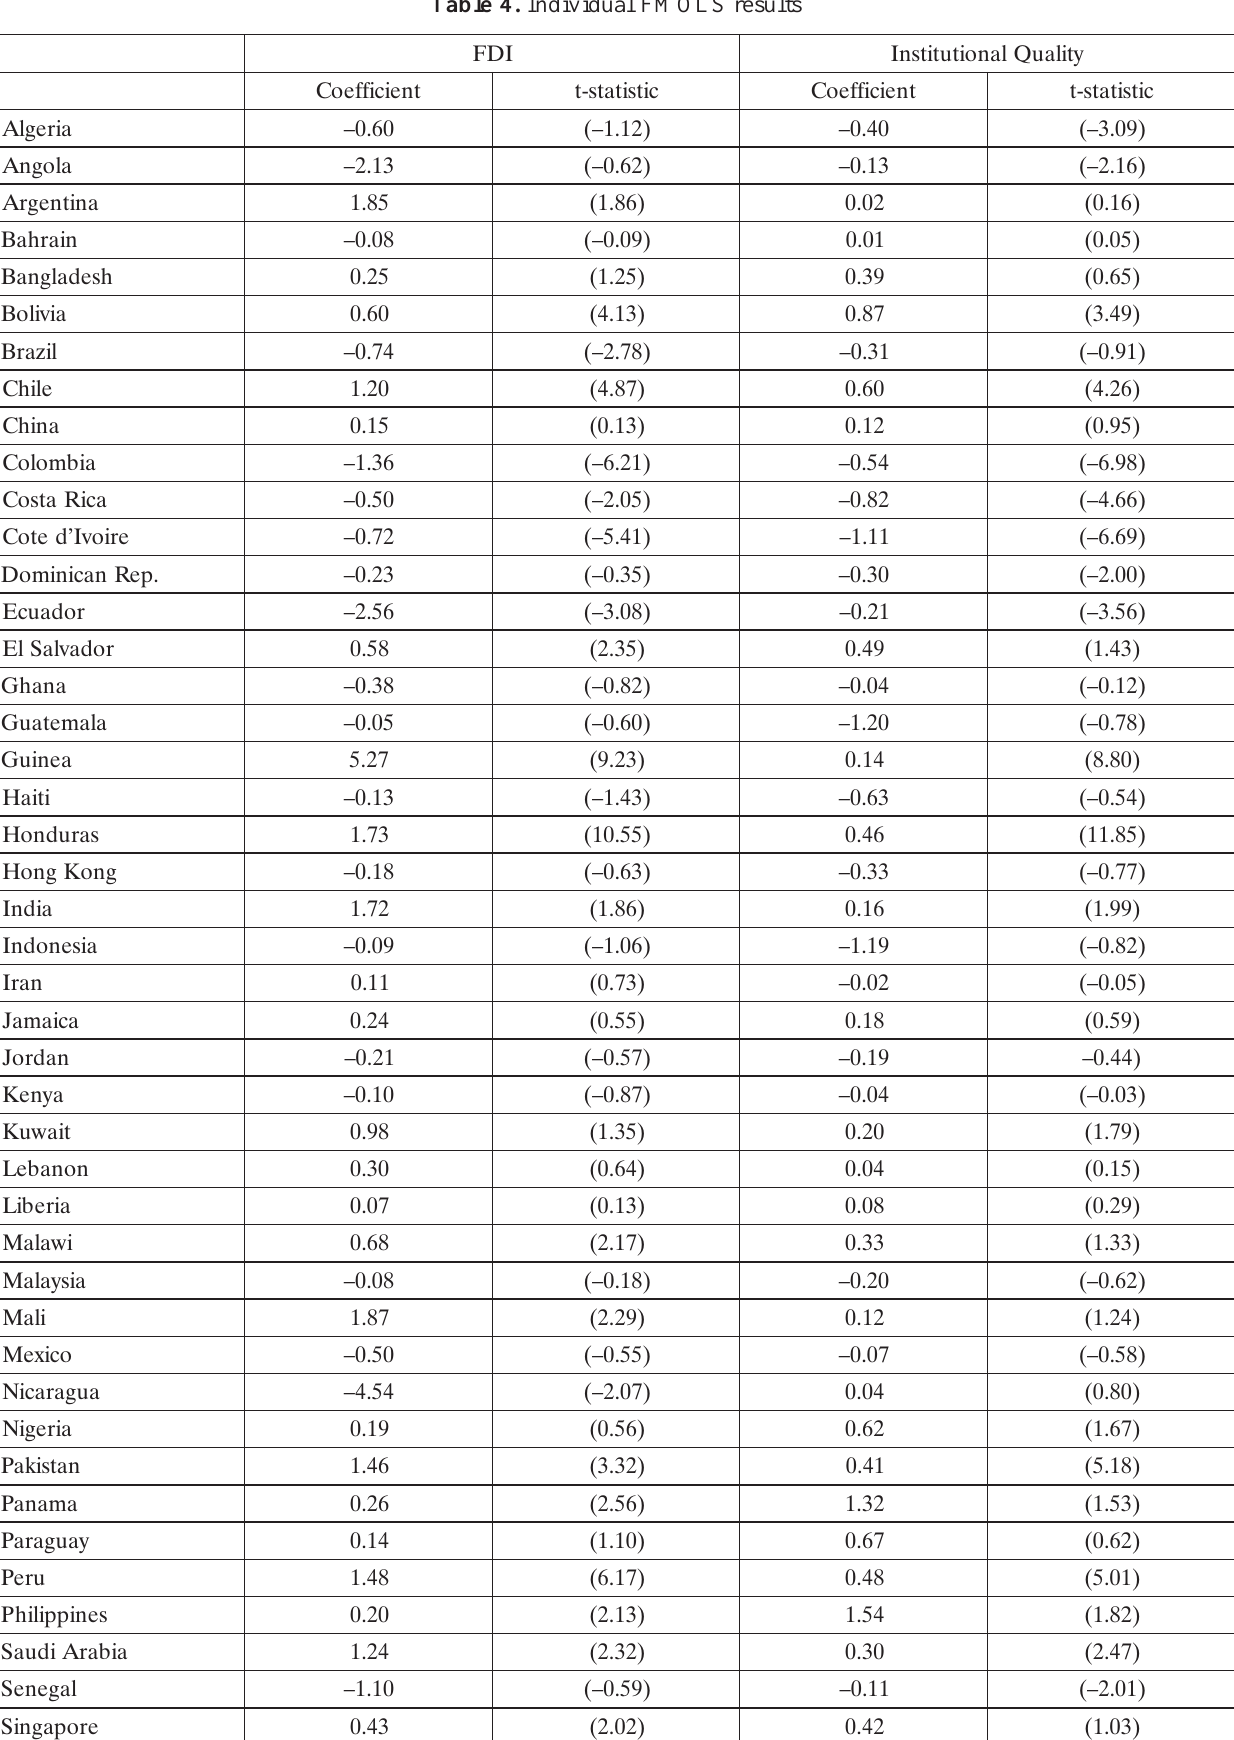
Table 4. Individual FMOLS